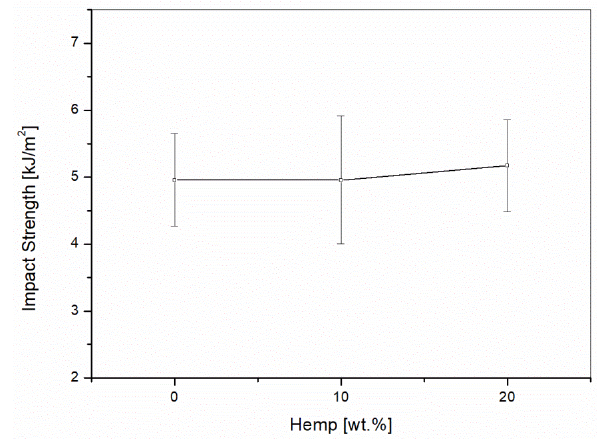
Figure 9. Impact testing of the 60/40 PP/LV blends with different contents of hemp fibers.